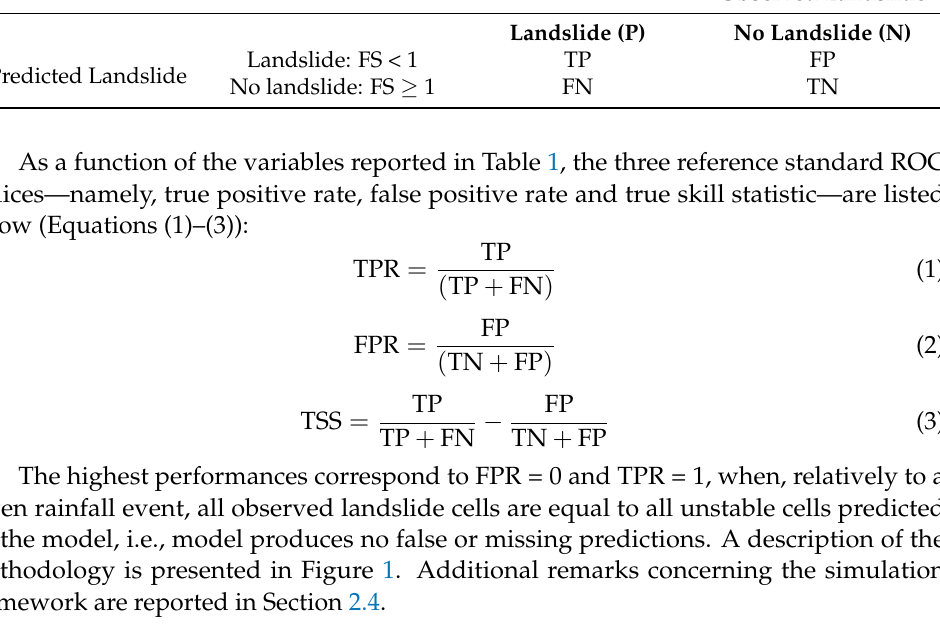
Table 1. Confusion matrix for receiver-operating characteristics (ROC) analysis. Predicted